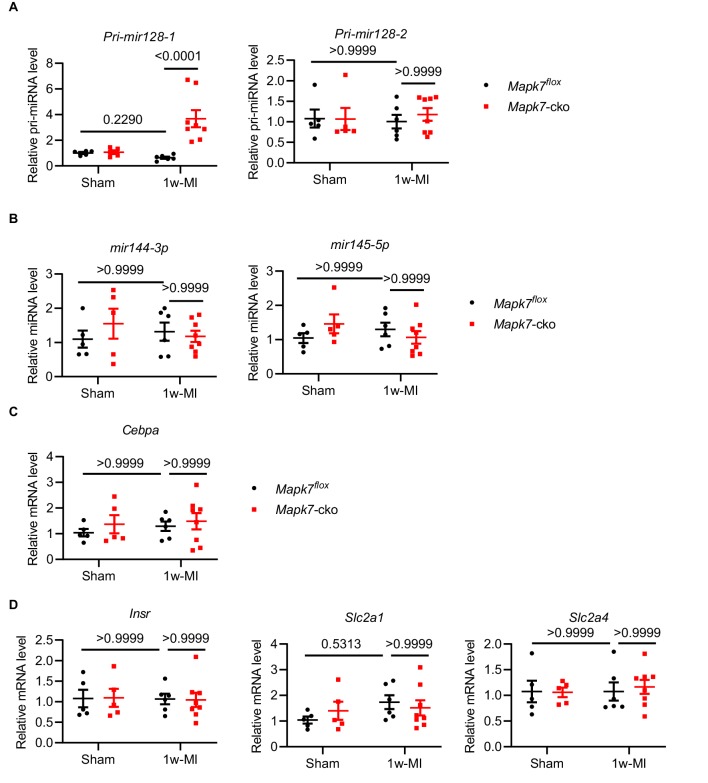
Gene expression comparison between Mapk7flox and Mapk7-cko mice one week post-MI.Real-time qPCR detection of (A) Pri-mir128-1 and Pri-mir128-2, (B) mir144-3p and mir145-5p and (C) Cebpa in Mapk7flox and Mapk7-cko subject to 1 week MI (N = 5–8 mice). (D) qPCR determined that Insr, Slc2a1 and Slc2a4 transcripts levels were not altered in Mapk7-cko one week post-MI (N = 5–8 mice). Data werenormalized against 18S or mir191-5p. Data presented as mean ± SEM. Two-way ANOVA followed by Bonferroni post hoc tests was employed to compare groups.Figure 4—figure supplement 2—source data 1.Gene expression comparison between Mapk7flox and Mapk7-cko mice one week post-MI.